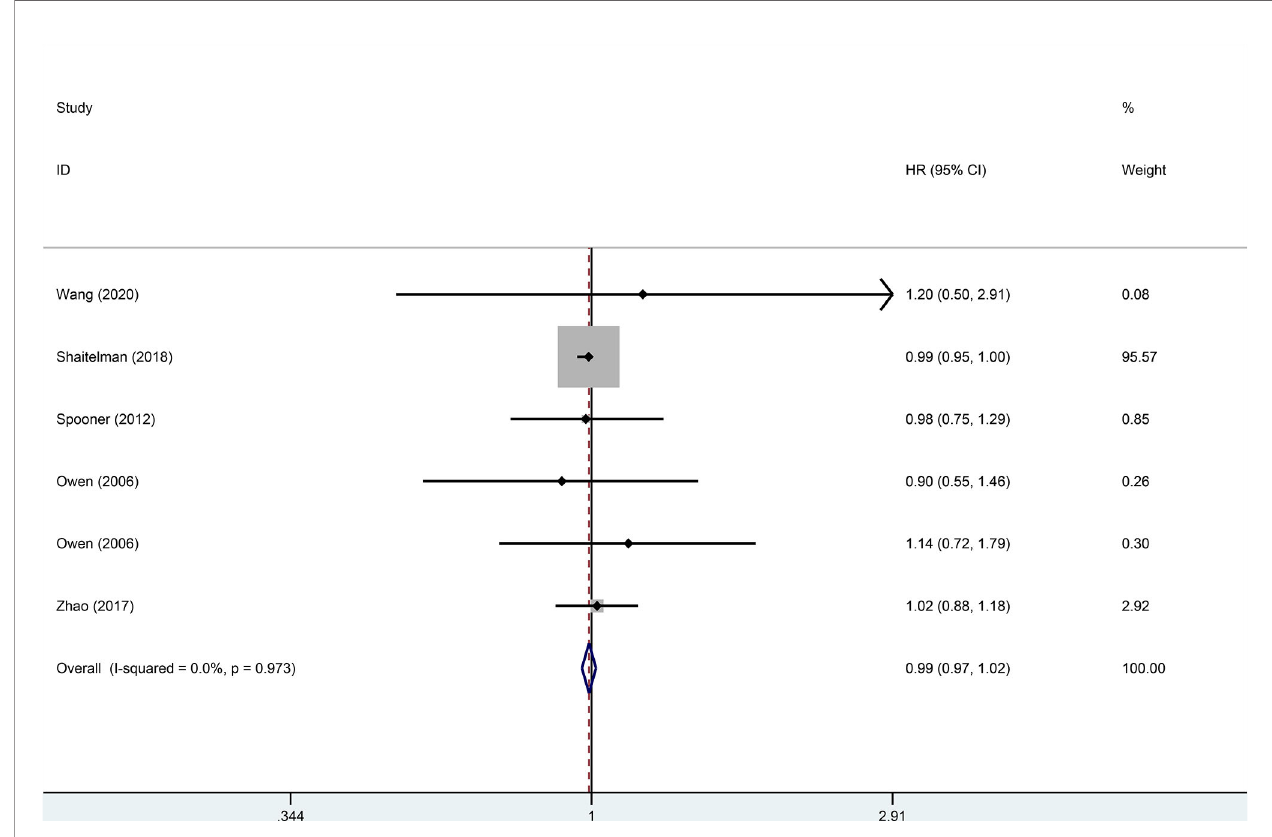
FIGURE 3 | Forest plot of hypofractionated radiotherapy (HFRT) vs . conventional radiotherapy (CFRT) for relapse-free survival ( p =